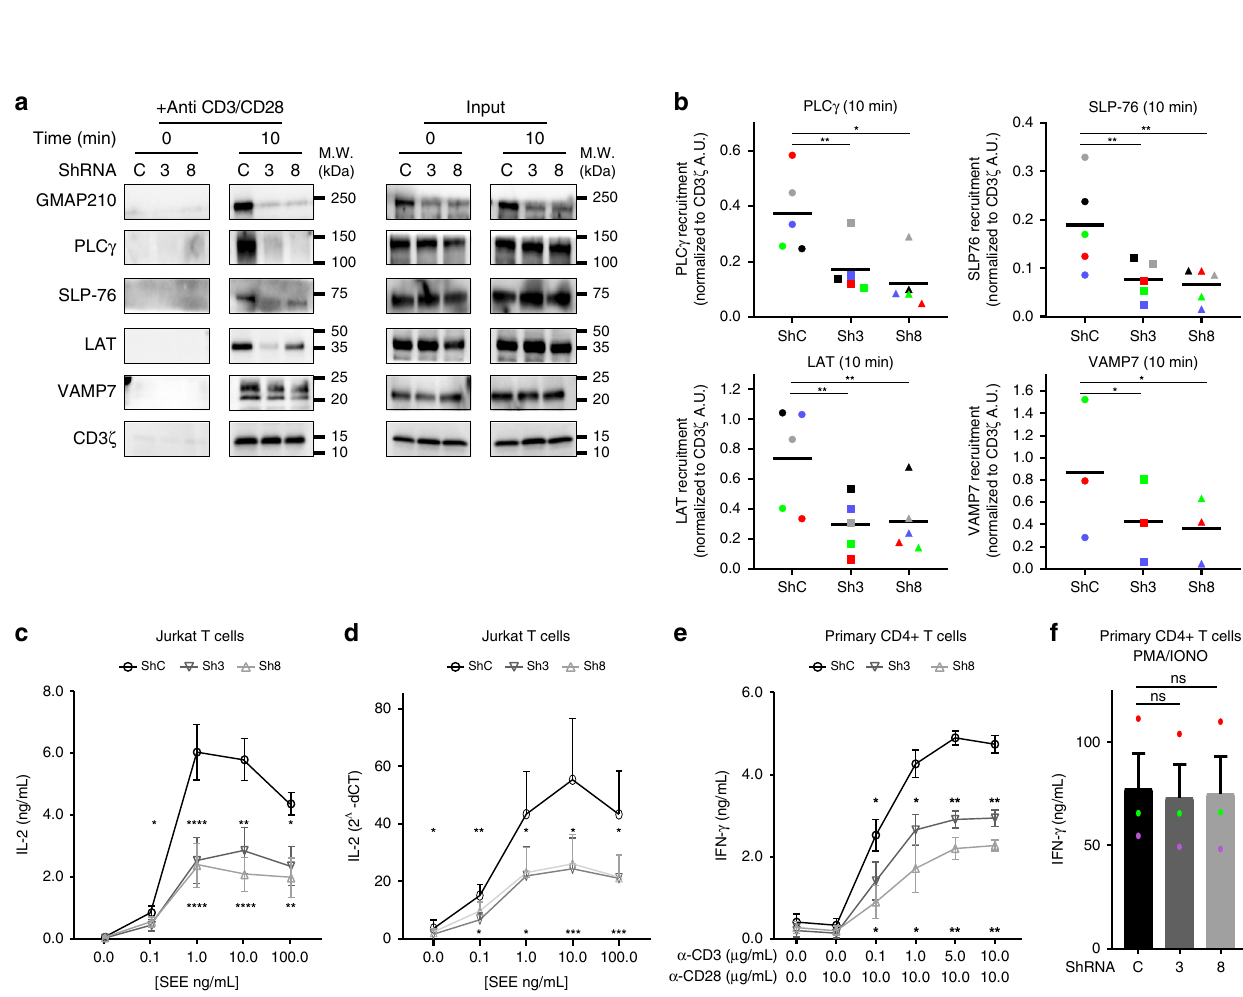
Fig. 4 GMAP210 silencing inhibits activation of T lymphocytes. a Immunoblot analysis of signalosomes prepared from Jurkat cells expressing control (C) or GMAP210 speci fi c ShRNA (3, 8) activated for 0, or 10 min with magnetic beads coated with mAb to CD3 ε and to CD28 (above blots). Proteins attached to the beads were puri fi ed by magnetic sorting after freezing and thawing of the cells without detergent (anti-CD3/CD28). Presence of the different proteins in the corresponding cell lysates are shown in “ input ” lanes. b Quanti fi cation of PLC γ , SLP-76, LAT, and VAMP7 band intensities at 10 min of activation and normalized on CD3 ζ intensity band. c and e Enzyme-linked immunosorbent assay of IL-2 in supernatants of Jurkat cells ( c ) or IFN- γ in human primary CD4 + T cells ( e ) expressing control (circle) or GMAP210-speci fi c ShRNA (triangle) and activated for 6 h by Raji B cells pulsed with various concentrations (horizontal axis) of SEE ( c , Jurkat T cells) or anti-CD3 in the presence of 10 μ g/mL of anti-CD28 ( e , human primary T cells). d Quantitative PCR analysis of IL-2 in Jurkat cells activated as in c ). f Enzyme-linked immunosorbent assay of IFN- γ in supernatants of human primary CD4 + T cells expressing control (ShC) or GMAP210-speci fi c ShRNA (Sh3 and Sh8) and activated for 6 h with a combination of PMA + ionomycin that bypasses LAT-signaling. * P < 0.05, ** P < 0.01, *** P < 0.001, **** P < 0.0001, ns: non-signi fi cant (paired parametric t -tests, one tail). Mean is represented by horizontal lines in b and each experiment is represented by one color. Data represent between three and fi ve experiments in a , b , c, and e , and three experiments in d and f